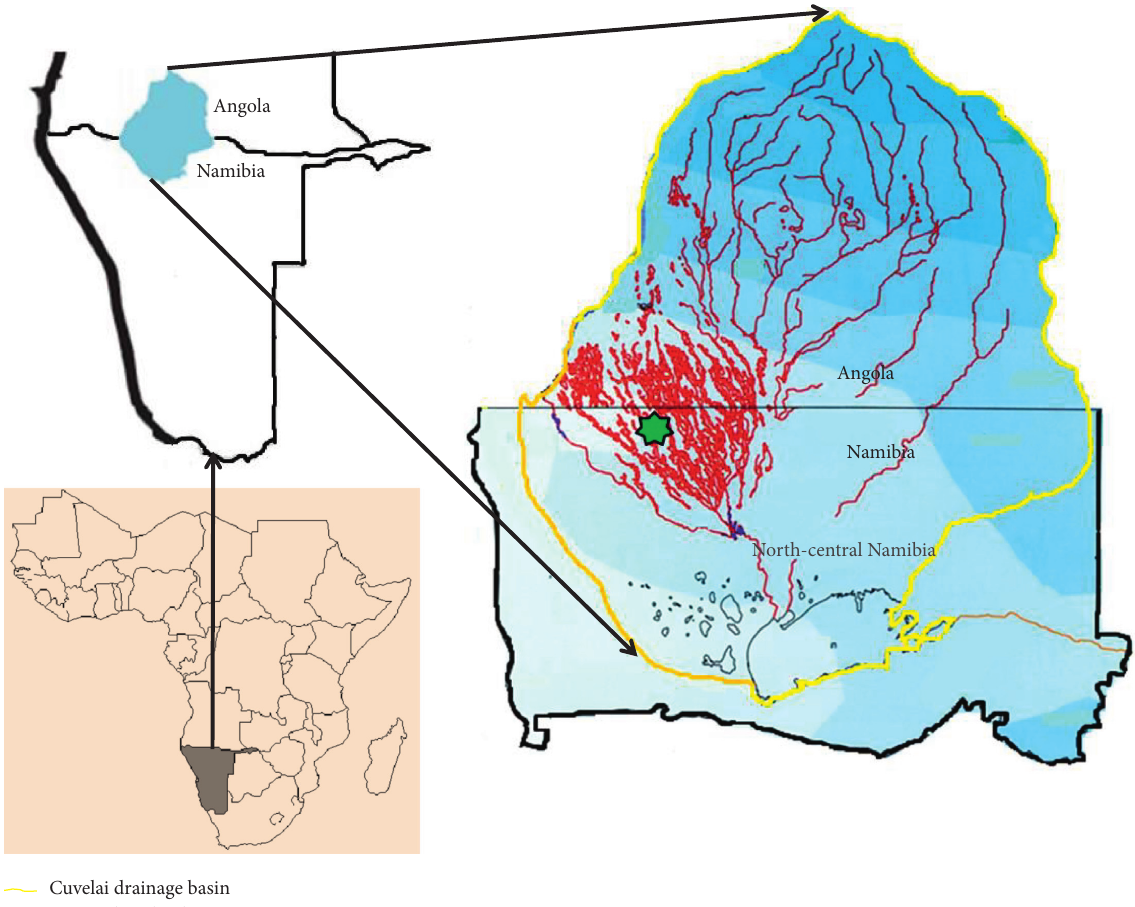
Figure 1: The Cuvelai Drainage Basin with seasonal wetlands formed in southern Angola and north-central Namibia where Ogongo Campus is situated. Adapted from [27,